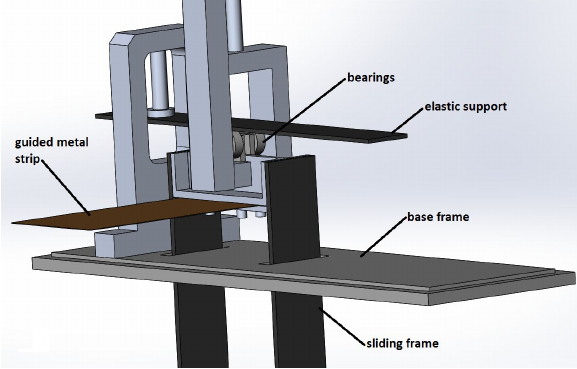
Fig. 3. The scheme of upper part of the sliding support